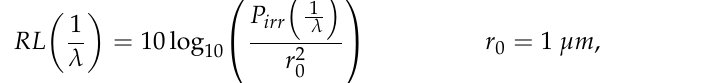
Figure 10. Speed profile and moving rms of the vertical acceleration measured at the axleboxes of the leading wheelset of the instrumented bogie: ( a ) day 1; ( b ) day 7.